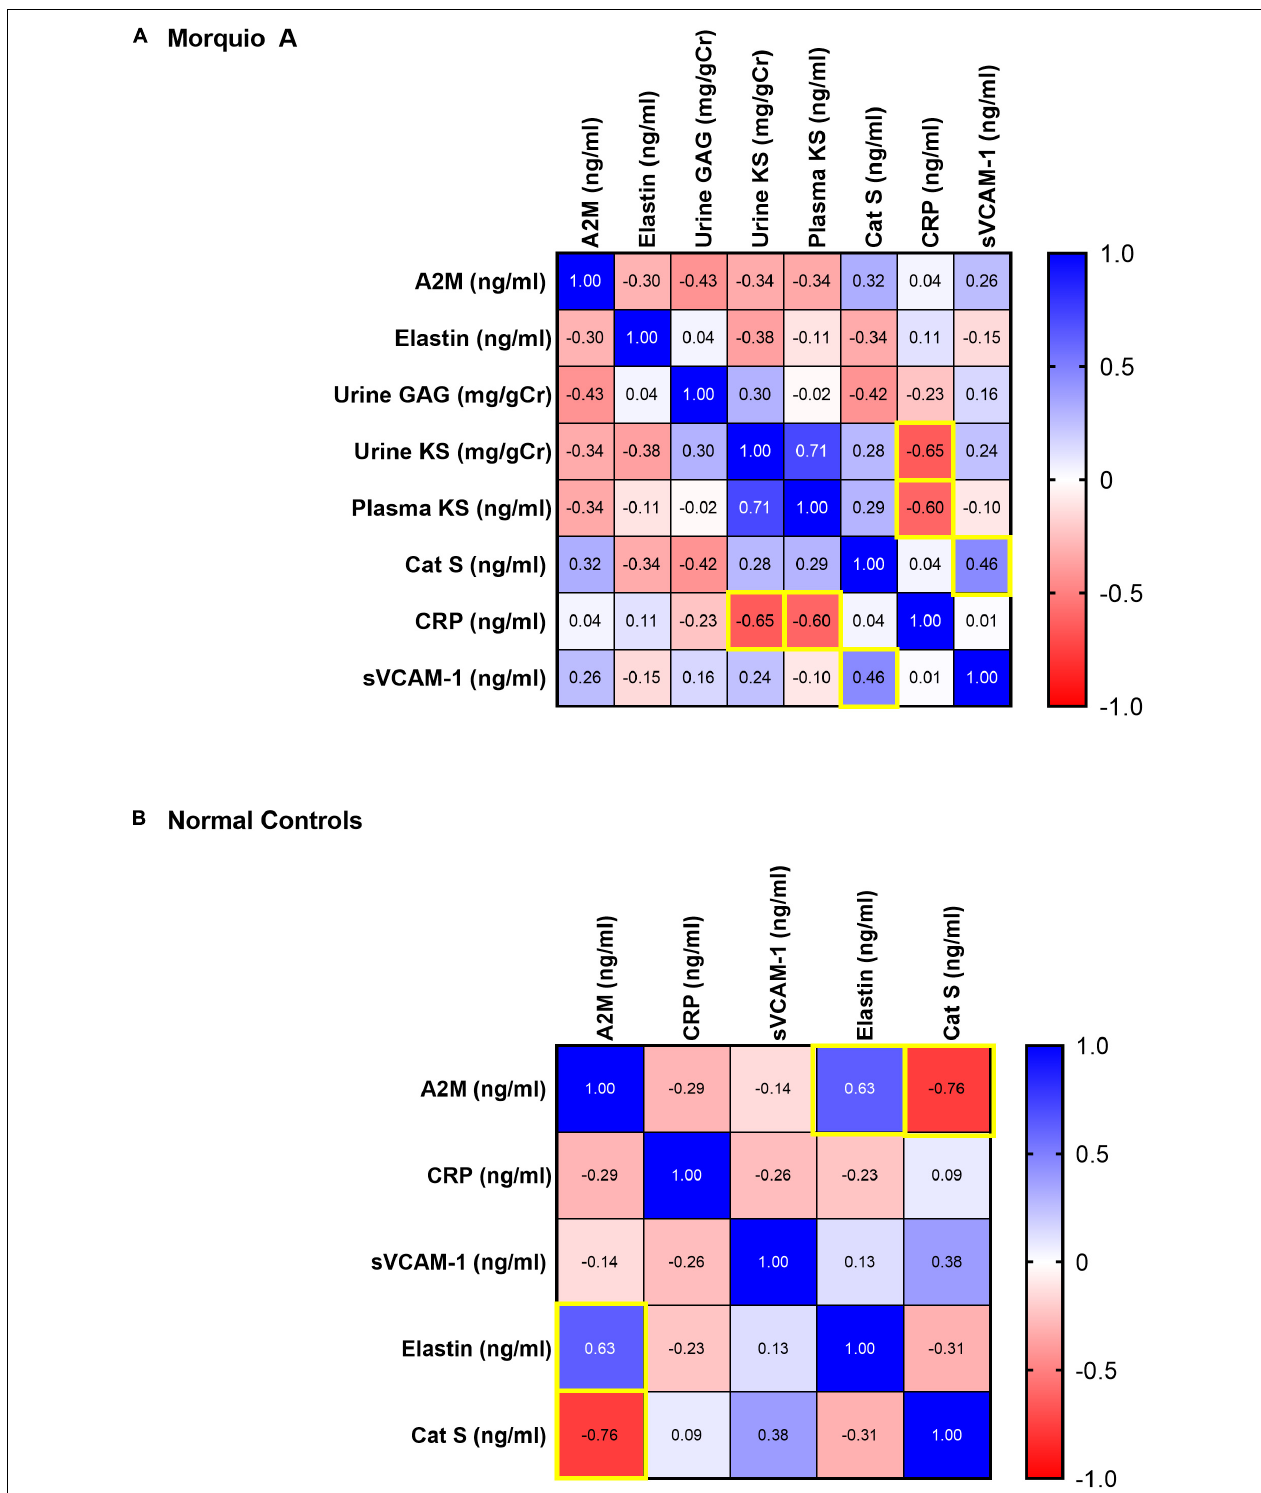
FIGURE 7 | Pairwise Pearson correlation matrix of (A) α -2-macroglobulin (A2M), C-reactive protein (CRP), circulating vascular cell adhesion molecule-1 (sVCAM-1), elastin, cathepsin S, keratan sulfate (KS), and glycosaminoglycans (GAGs) in Morquio A samples, and (B) A2M, CRP, sVCAM-1, elastin, and cathepsin S in normal controls. Blue indicates positive correlation, and red indicates negative correlation. Darker colors are associated with stronger correlation coefficients. Yellow boxes indicate significant correlations.